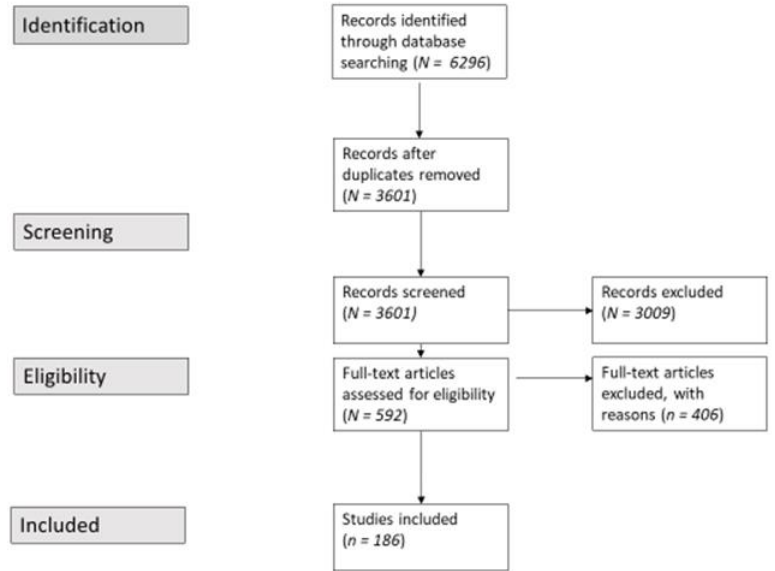
Figure 2. Flow chart for reporting the results of scoping review (derived from Peters et al., 2015, p. 144). N equals the sum of the results from four separate search strings adhering to the four domains of children’s and young people’s ICT use : family, leisure, education and civic participation.